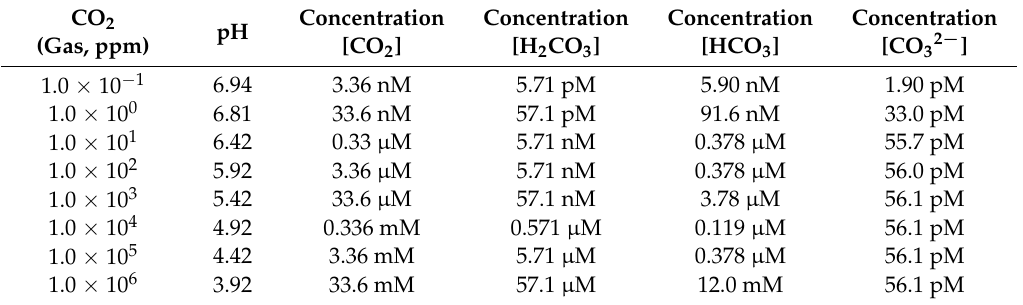
Table 1. The CO 2 concentrations in the atmosphere, pH value, and equilibrating species concentrations.